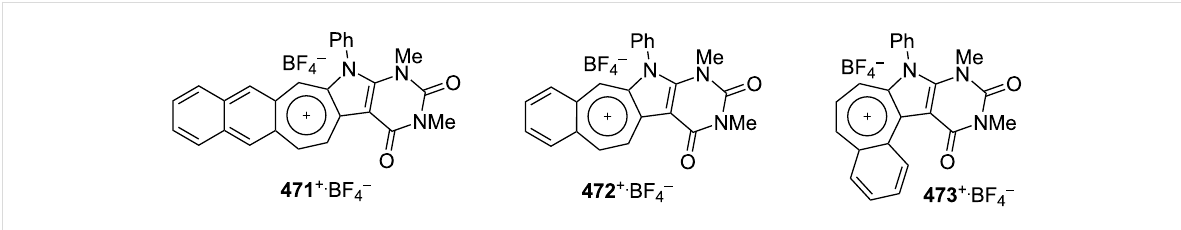
Figure 31: Structures of tropylium ions 471 +. BF 4 − , 472 +. BF 4 − , and 473 +. BF 4 − .